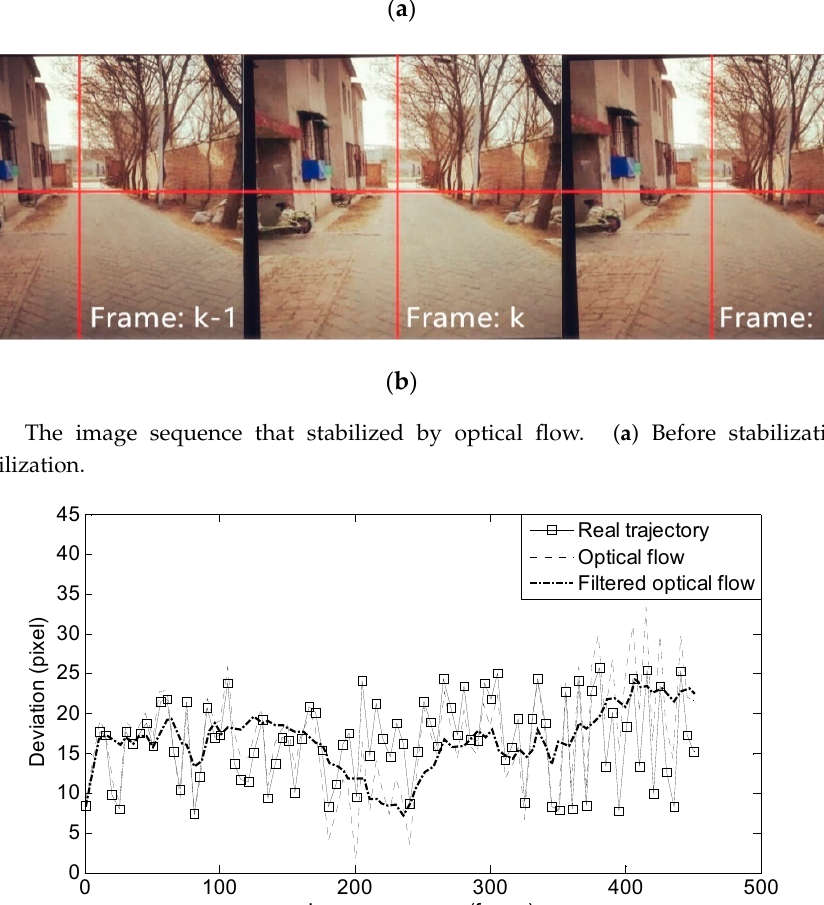
Figure 3. Simulation results of pyramid LK (Lucas-Kanade) optical flow algorithm.